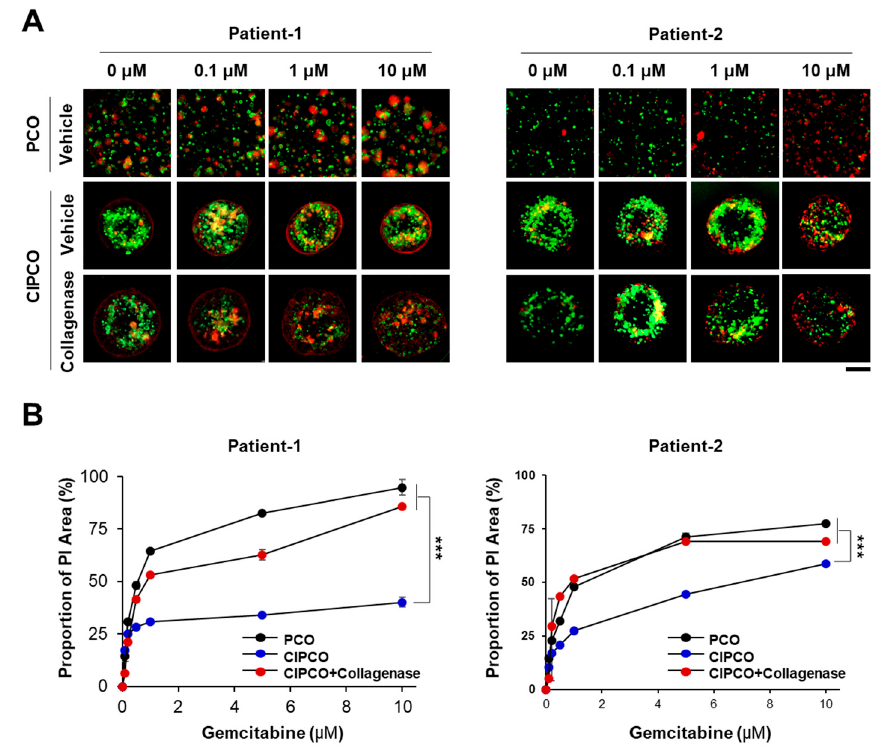
Figure 4. Sensitivity of cancer cells to gemcitabine in PCO and CIPCO models. ( A ) Immunofluores- cence detection of propidium iodide (PI) in PCOs and CIPCOs treated with various concentrations of gemcitabine (range: 0.1–10 µM). For the CIPCO, collagenase (100 ng/mL) was added. (green: live PCOs; red: dead cells). ( B ) Quantitative analysis of PI-positive areas. PI-positive areas were calcu- lated using Gen5 Image Prime 3.08 (Biotek). Bar = 200 µm. *** p < 0.001.